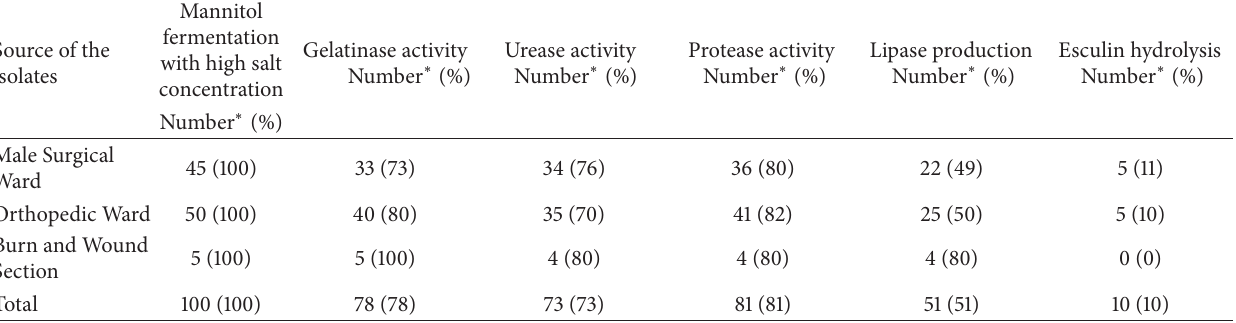
Table 3: Important biochemical markers of Staphylococcus aureus isolates.